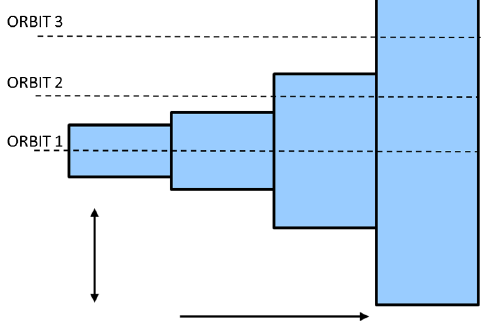
m.FIG. 8. Top view of the corrugated plate. Electron beams with different offsets see different lengths of the